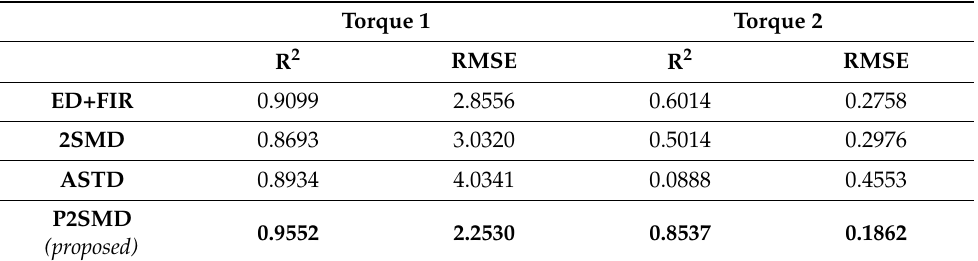
Table 5. Results obtained for cross-validation in terms of R 2 and RMSE. The best results are shown in